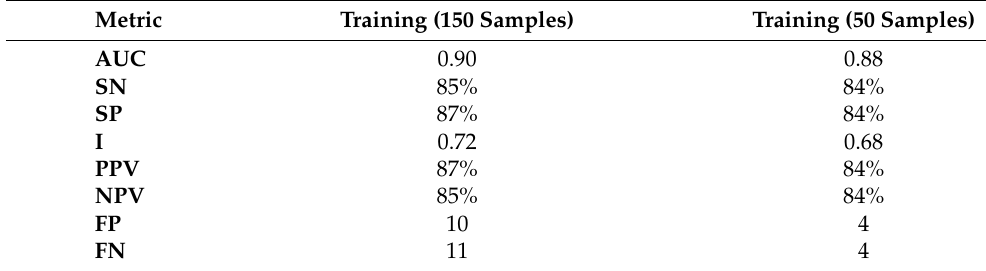
Table 3. Performance of the radiomic model in the training and test sets Metric Training (150 Samples) Training (50 Samples) AUC 0.90 0.88